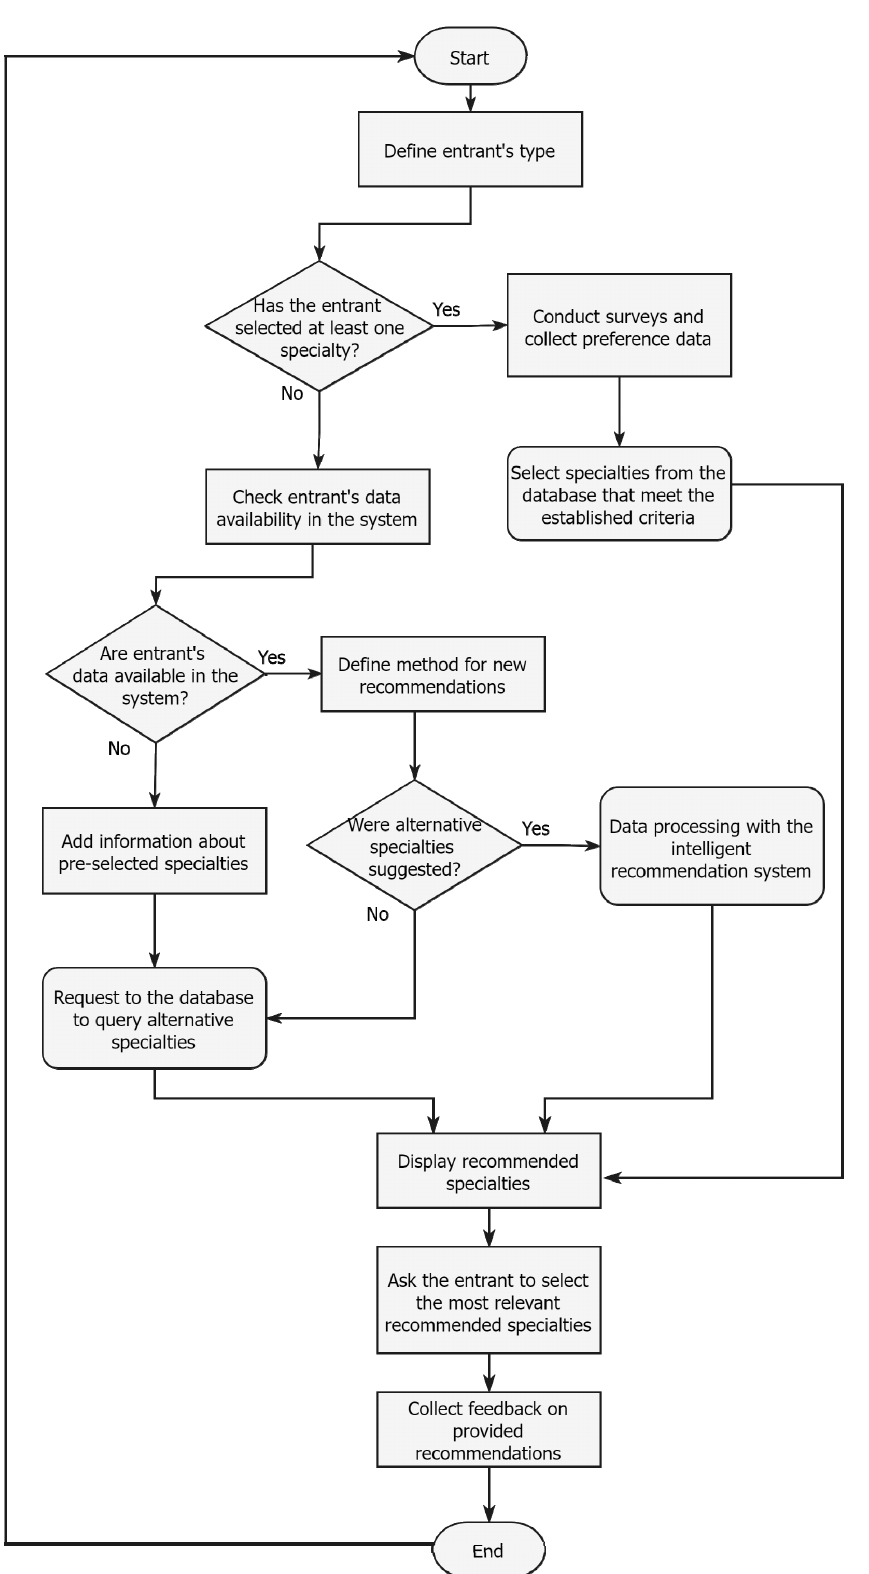
Figure 2. Specialty recommendation system algorithm of actions.